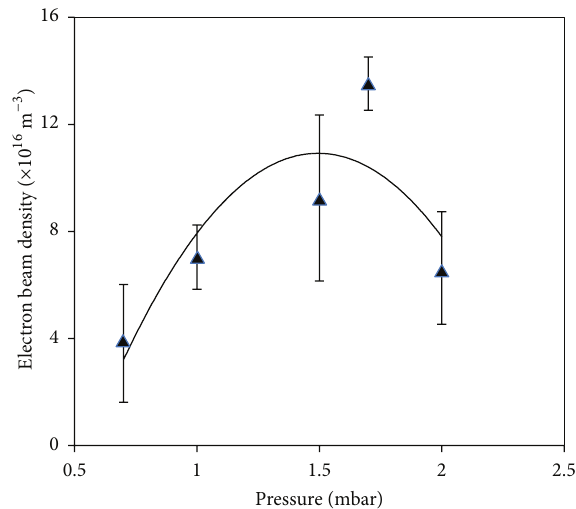
Figure 13: Variation of electron beam density versus Argon gas pressure.